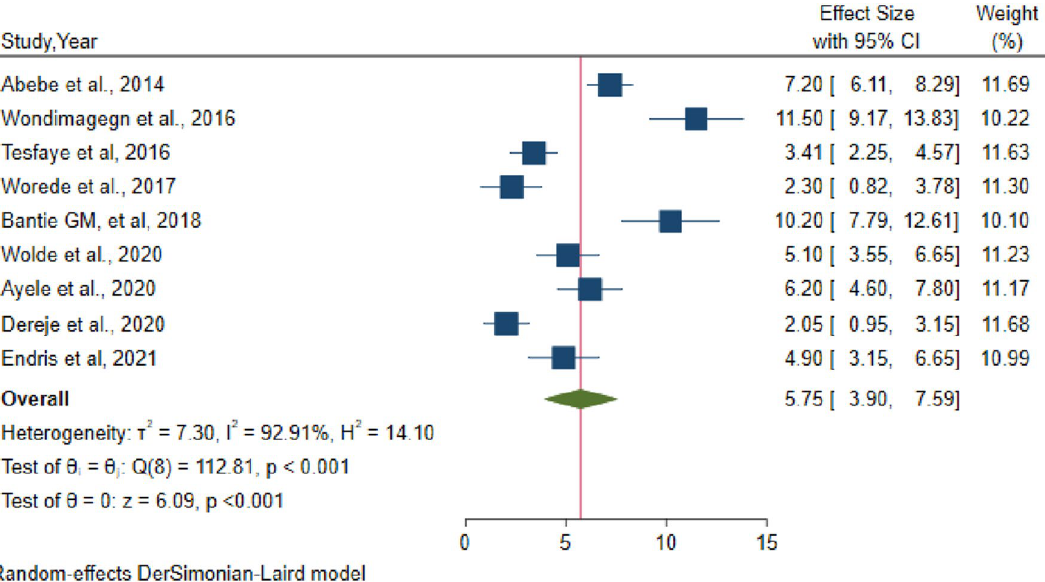
Figure 2. Forest plot of pooled prevalence of undiagnosed diabetes mellitus in Ethiopia, 2021.